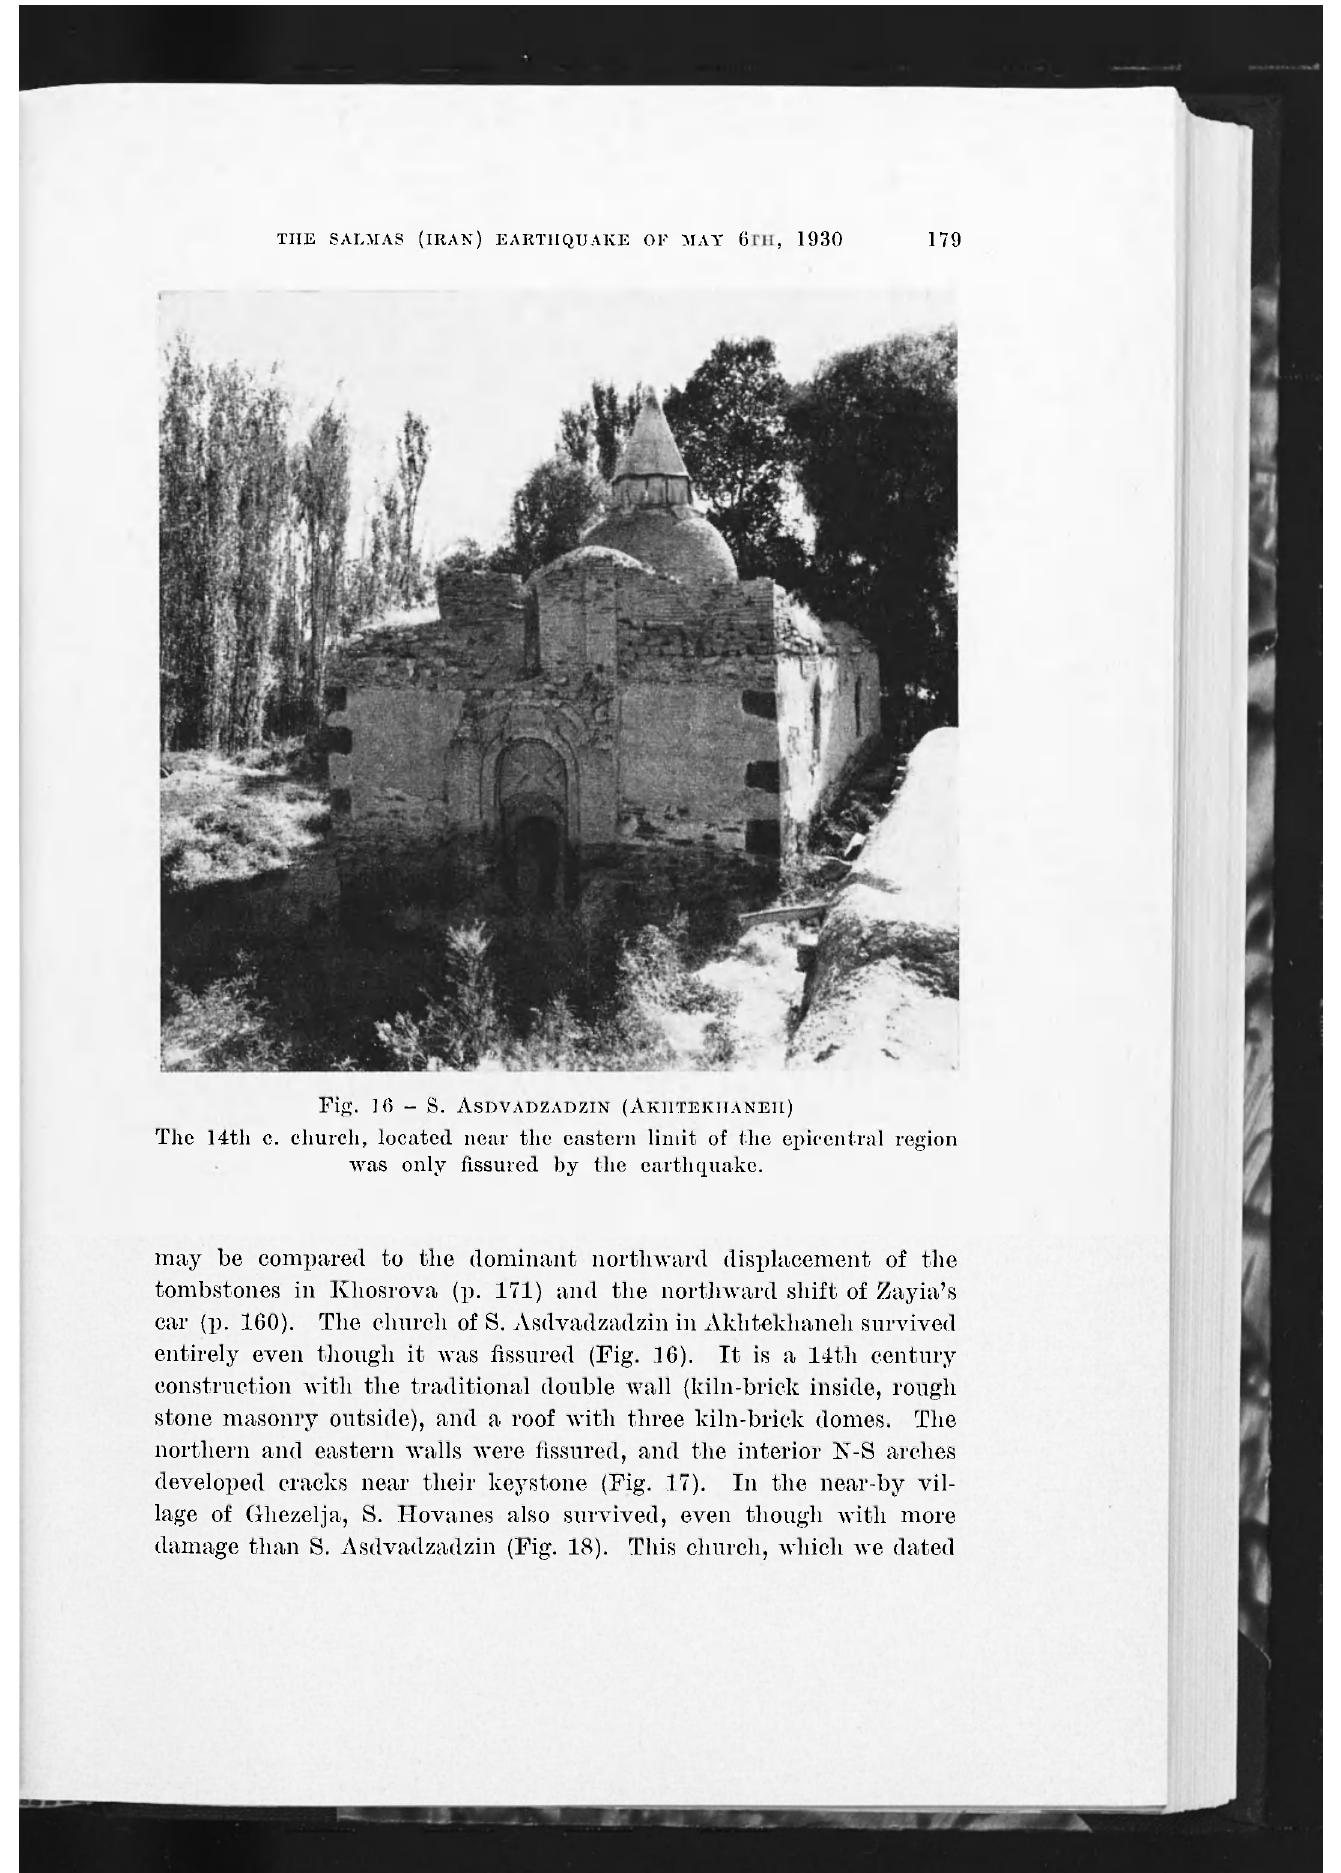
Fig. 16 - S. ASDVADZADZIN (AKIITEKHANEH) The 14th c. church, located near the eastern limit of the epicentral region was only fissured by the